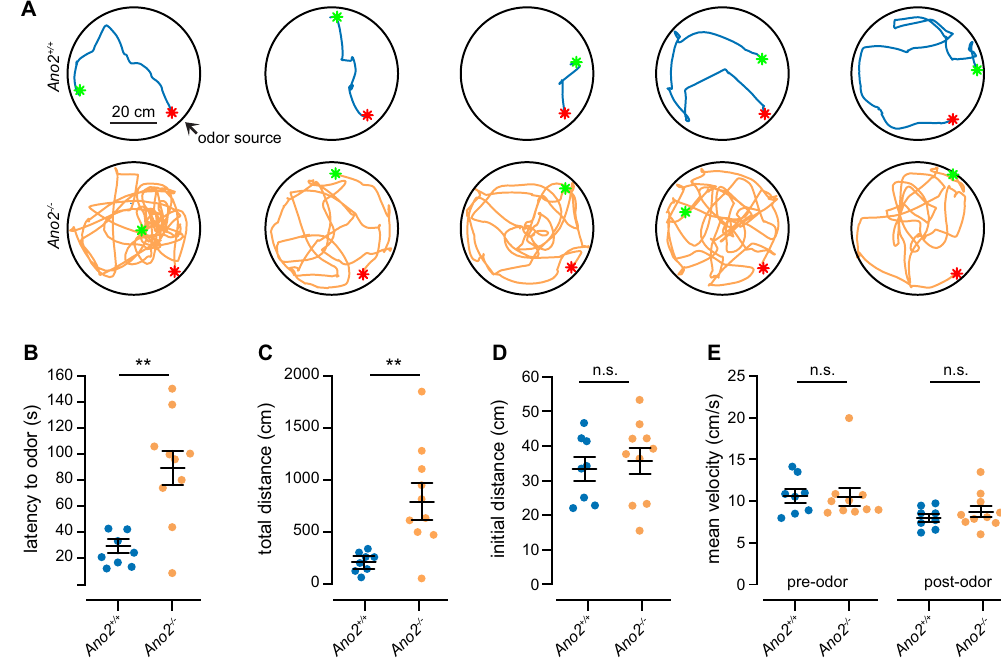
Figure 6. Latency to odor localization is increased in Ano2 − / − animals. ( A) Examples of five Ano2 + / + and Ano2 − / − animals tracking to the source of odorized air carrying a 1% dilution of peanut oil. Green and red asterisks mark the initial and final position of each animal. ( B) Time latency for animals to locate the odor source (n = 8 Ano2 + / + and 10 Ano2 − / − animals, p = 0.003, Wilcoxon rank-sum test). ( C) Total distance traveled before finding the odor source across all animals (p = 0.002, Wilcoxon rank-sum test). ( D) Initial distance from odor source (at odor onset) across all animals (p > 0.05, Wilcoxon rank-sum test). ( E) Mean velocity of each animal prior to and following odor onset (p > 0.05, Wilcoxon rank-sum